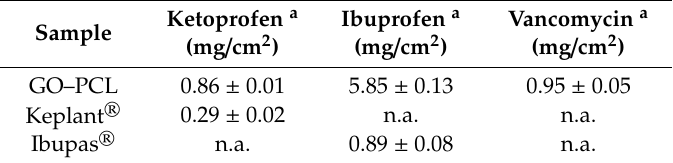
Table 1. Drug loading of GO–PCL compared with commercially available patches.